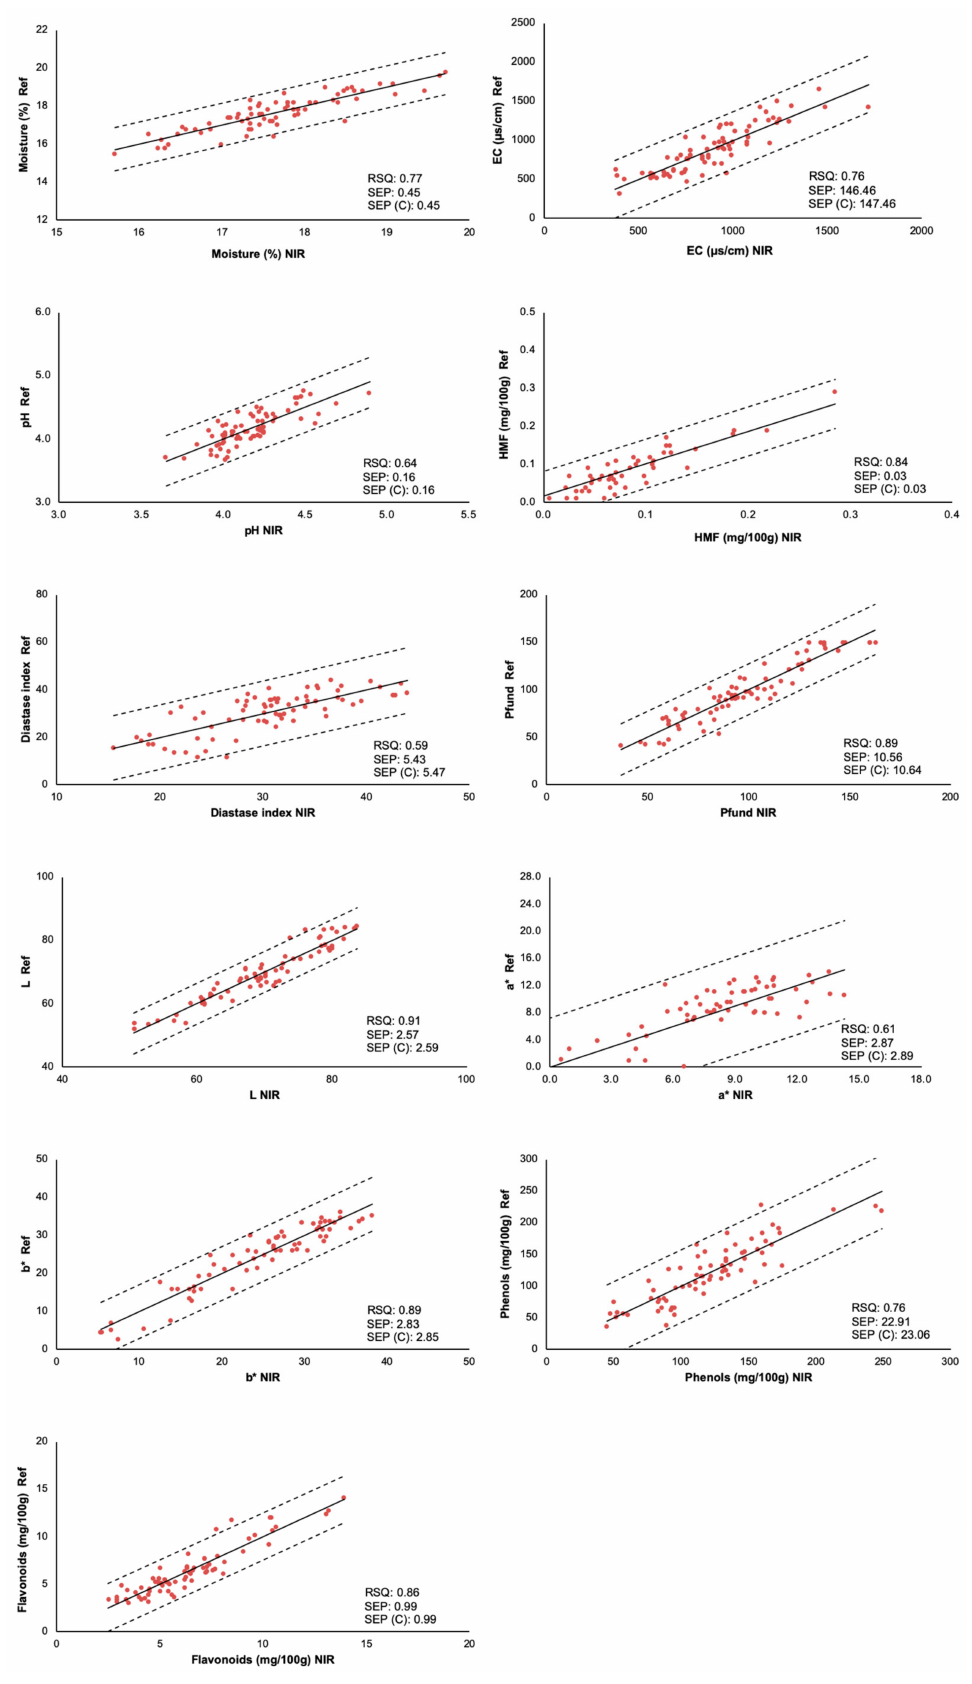
Figure 2. Measured references values versus the NIR values in the prediction set of honey